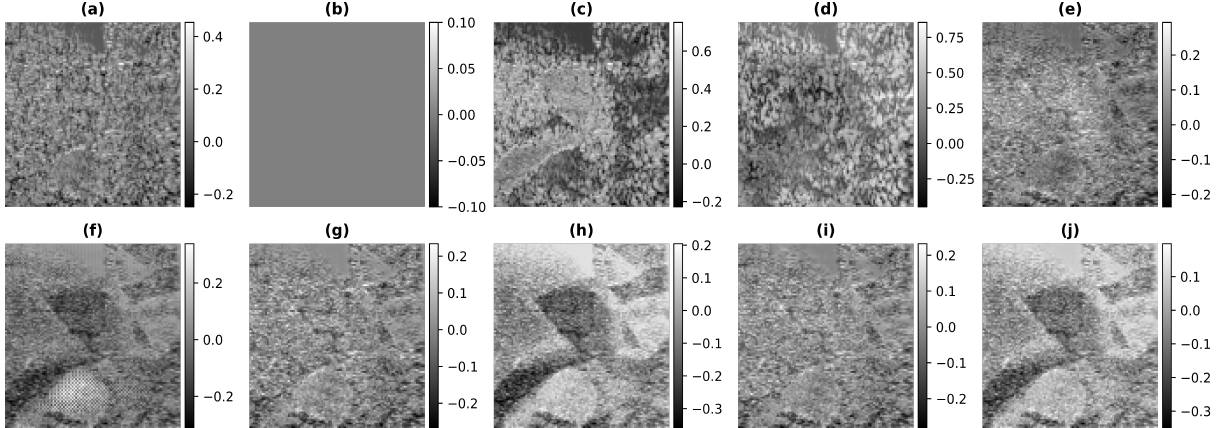
Figure 9. Results of the error of the bandwidth improvement for Phantom I for the different models ( a ) Band-limited image ( b ) Full Bandwidth image ( c ) Histogram Equalization ( d ) Contrast Limited Adaptive Histogram Equalization ( e ) U-Net-PL1 ( f ) U-Net-PL2 ( g ) SRCNN-PL1 ( h ) SRCNN-PL2 ( i ) REDNet-PL1 ( j )